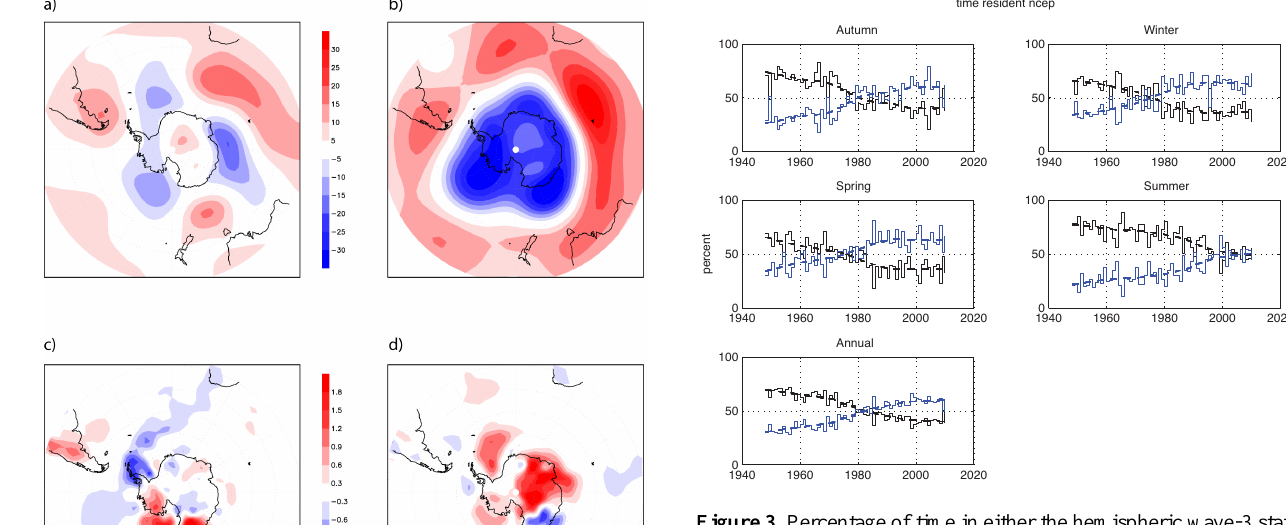
Figure 3. Percentage of time in either the hemispheric wave-3 state (black dashed) or the zonal state (blue dashed) for the NCEP reanal- ysis 500hPa geopotential height field for all seasons and annually. The dashed lines are a LOESS fit to the time-averaged data where the solid lines indicate the values and averaging periods of the